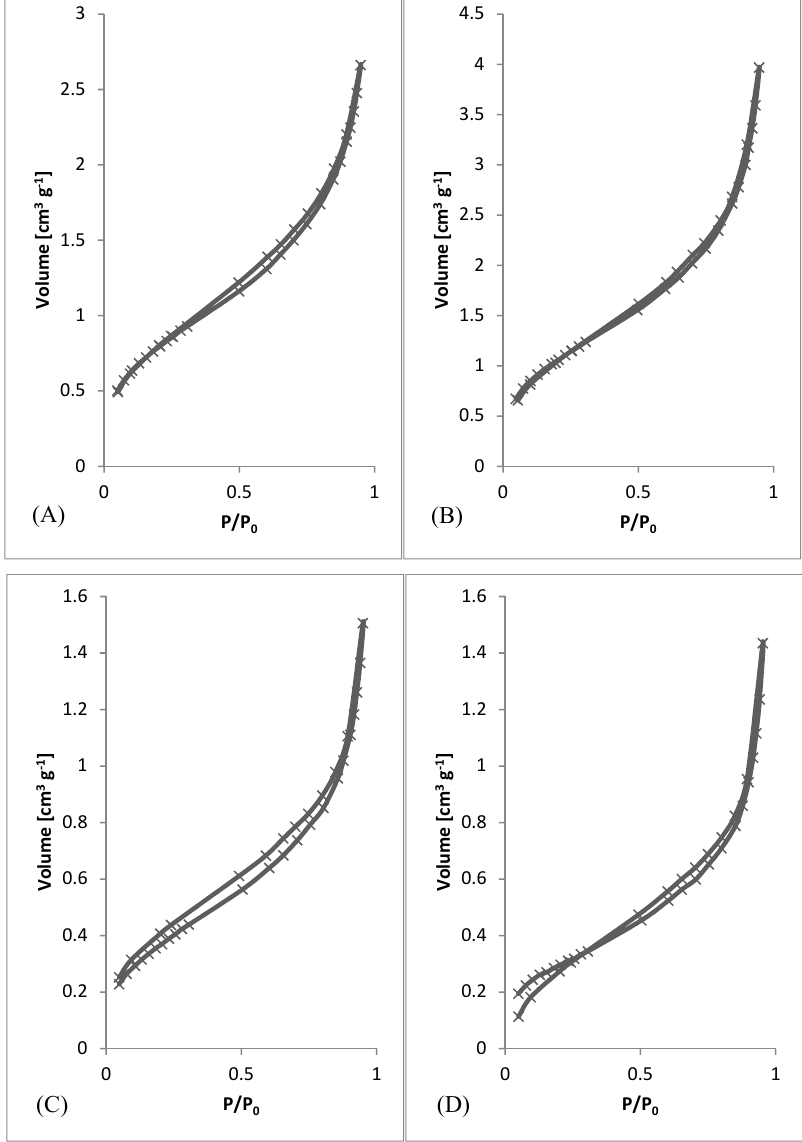
Figure 6. Adsorption / desorption Isotherms. ( A ) 3 wt.%; 3 ml.h − 1 , ( B ) 5 wt.%; 0.5 ml.h − 1 , ( C ) 7.5 wt.%; 8 ml.h − 1 , ( D ) 10 wt.%; 8 ml.h − 1 .